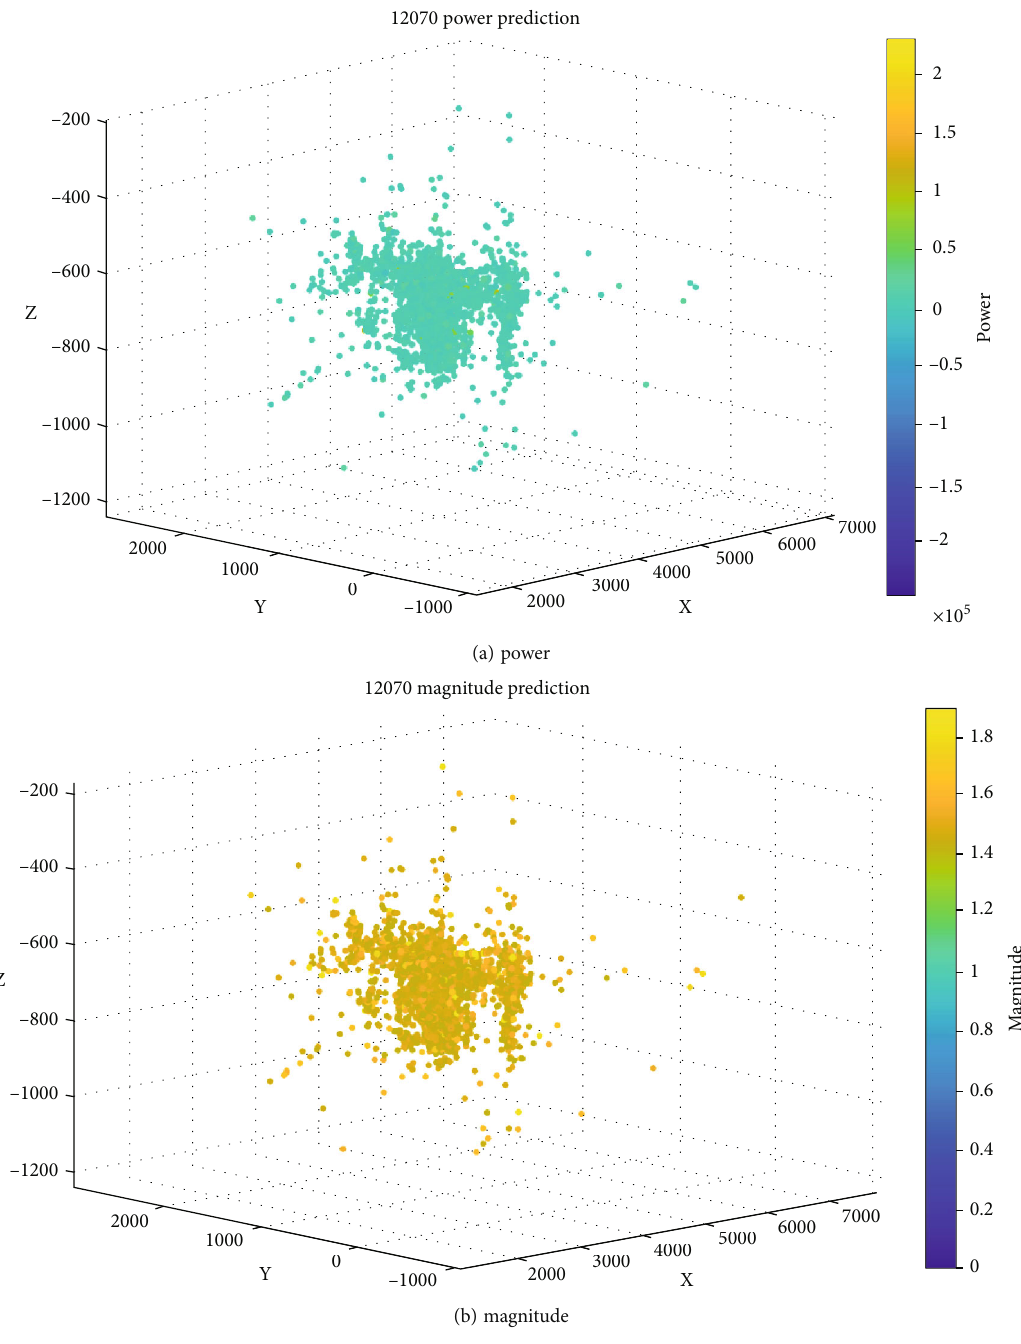
Figure 9: Prediction of power and magnitude of 12070 working face coal